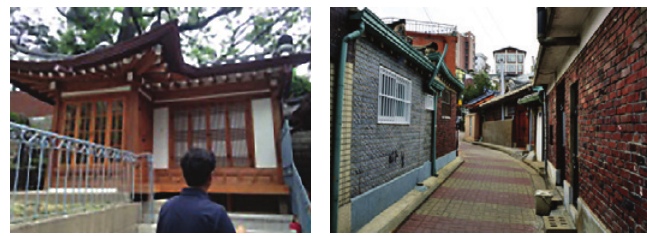
Figure 8. Traditional Korean Figure 9. An alleyway in